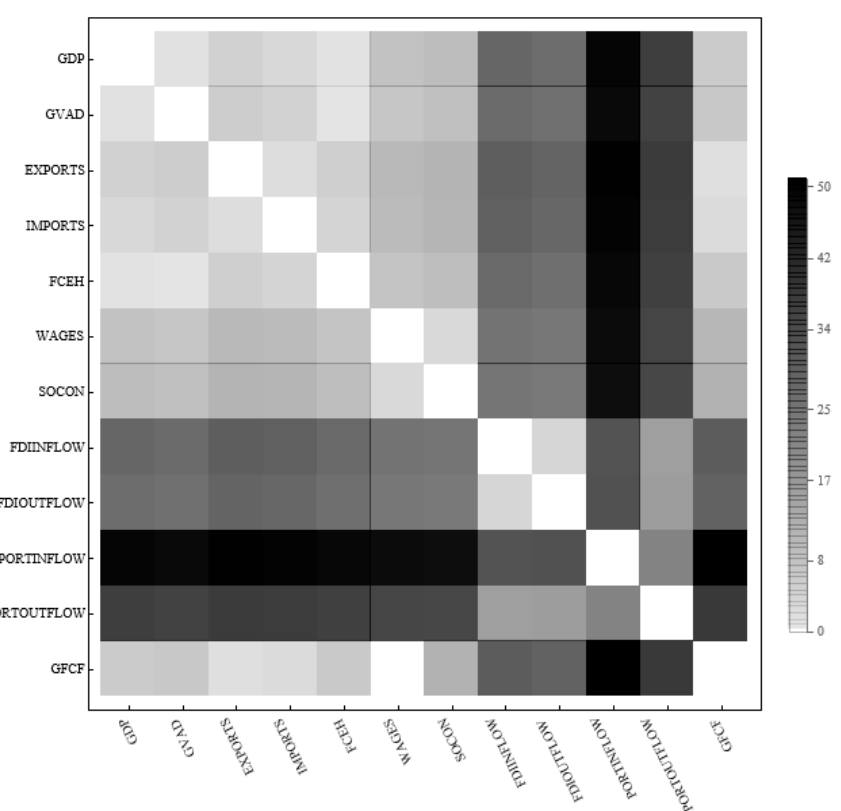
Figure 6. Wasserstein distance matrix of dominant layers .